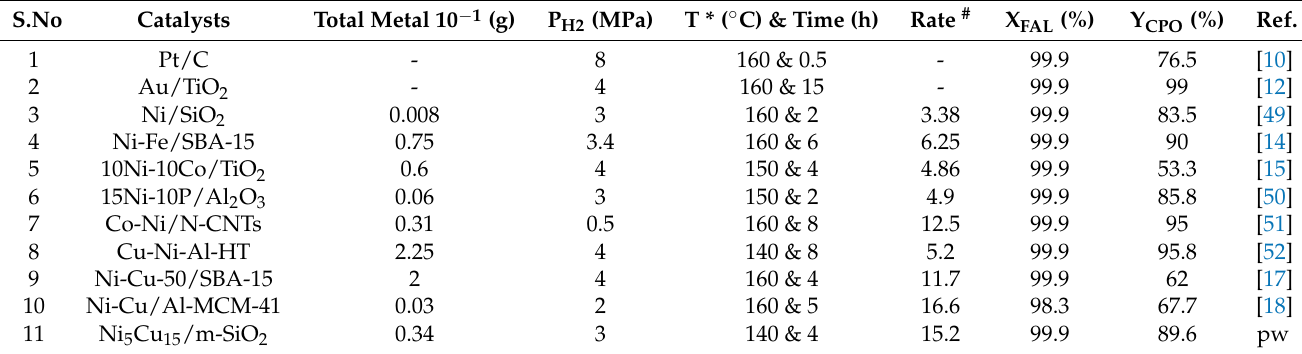
Table 3. Comparison of various catalysts reported in the literature on FAL hydrogenation to